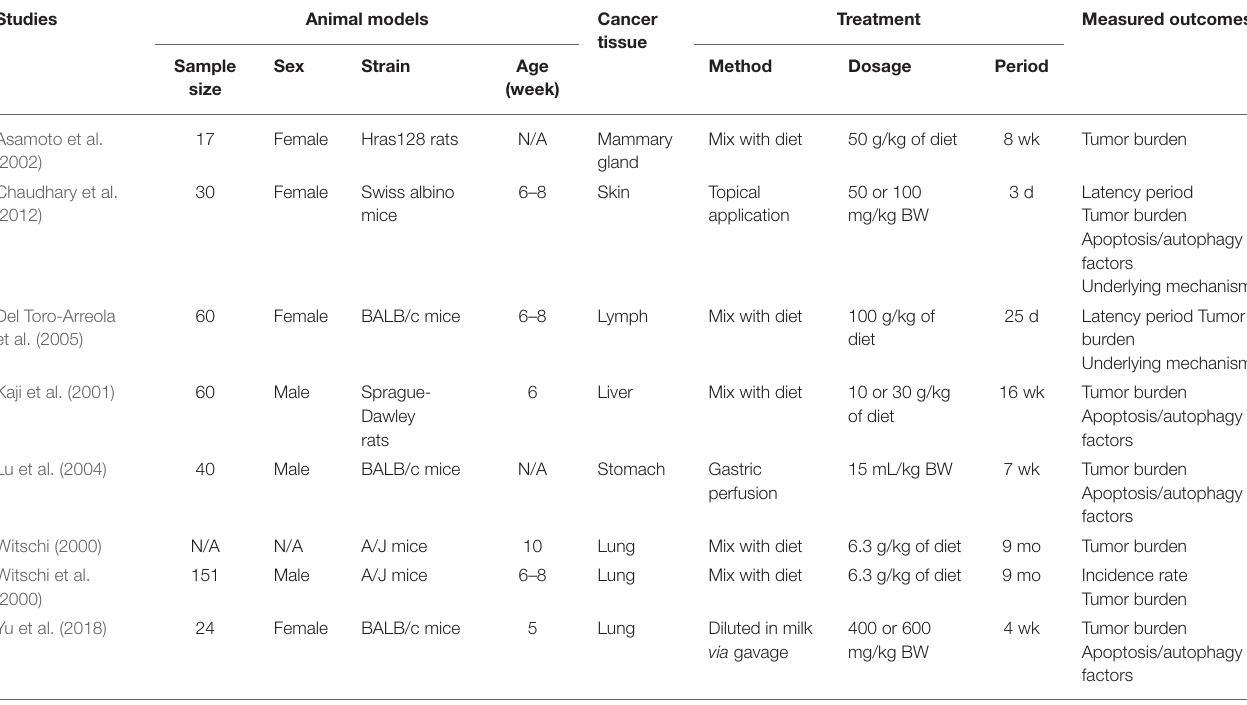
TABLE 1 | Characteristics of studies identified.